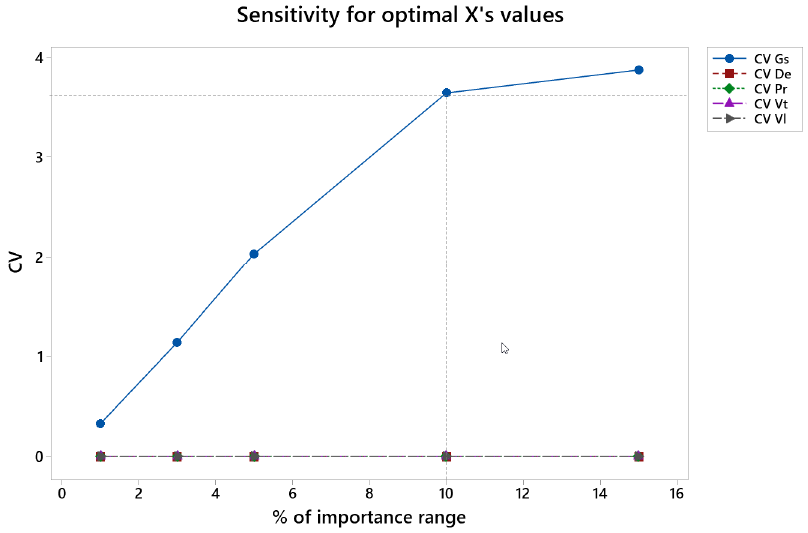
Figure 14. CV of the different factors vs. percentage of importance range in the semi-finish honing operation.